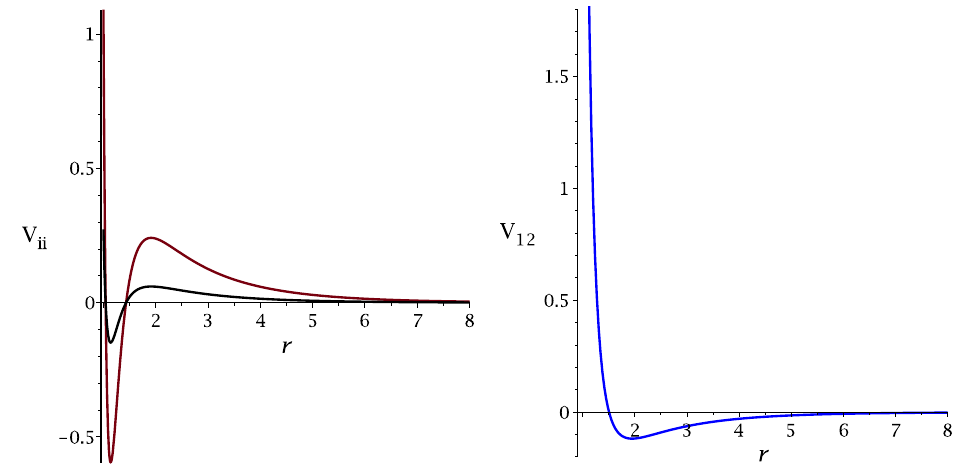
Figure 2. The interactions given in (3) in units of (cid:101) for q = 1/2. The ( left ) and ( right ) panels correspond to the interaction between like and different particles, respectively. The red and black lines correspond to the first and the second component particles,